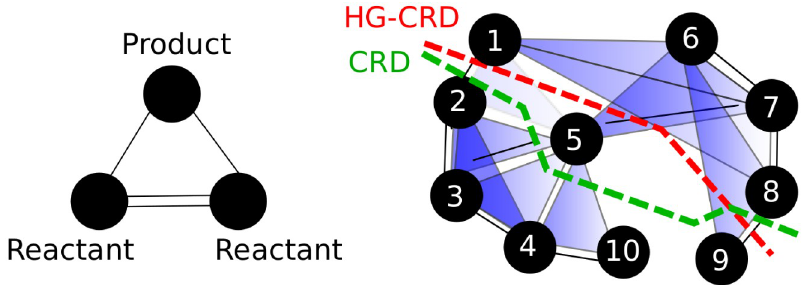
Fig 1. Running CRD and HG-CRD on the metabolic graph [15], shows that CRD returns a set with motif conductance of 0.33 while HG-CRD has motif conductance of 0.27. (Algorithm parameters for reproducibility: h = 2, C = 2, τ = 2, iterations = 5, α = 1 and starting from node 7.). The motif hypergraph has edges: {1,2,5}, {2,3,5}, {3,4,5}, {4,5,10}, {2,3,4}, {1,6,7}, {1,7,8}, {5,6,7} and